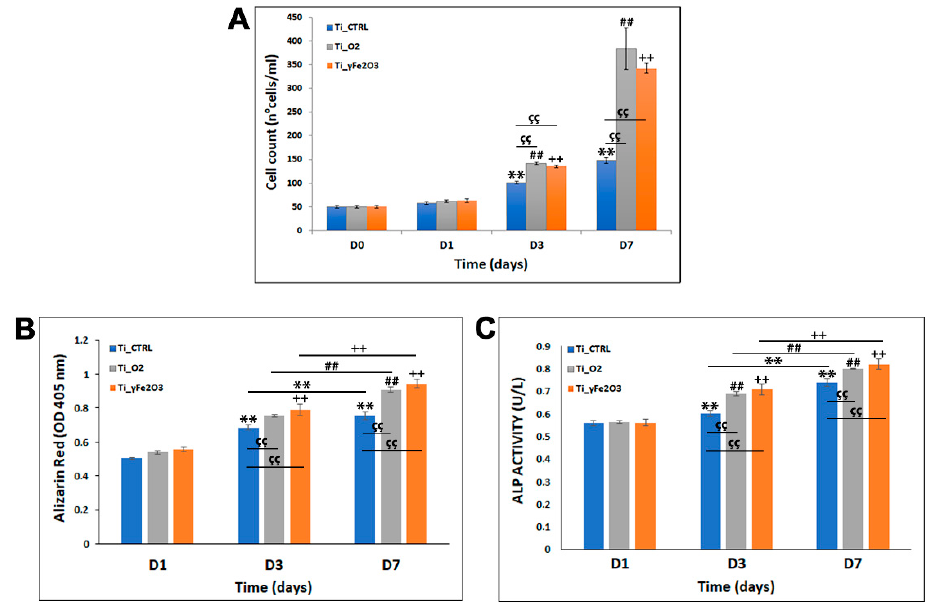
Figure 4. Cell proliferation analysis of hADSCs cultured on Ti_CTRL, Ti_TiO 2 and Ti_ γ Fe 2 O 3 scaffolds, for 7 days. ( A ) Trypan blue cell count at day 0 (D0 = plating day), day 1 (D1 = 24 h from plating), day 3 (D3 = 3 days from plating) and day 7 (D7 = 7 days from plating). Data are reported as mean ± standard deviation obtained on 3 scaffolds. ( B ) Alizarin Red S staining after 1, 3 and 7 days of cell culture. Data are shown as mean ± standard deviation. ( C ) ALP activity after 1, 3 and 7 days of cell culture. Data are shown as mean ± standard deviation. **, ## , çç , ++ p < 0.01 show significant differences between the different time points and scaffolds, as reported by the Holm post-hoc test.